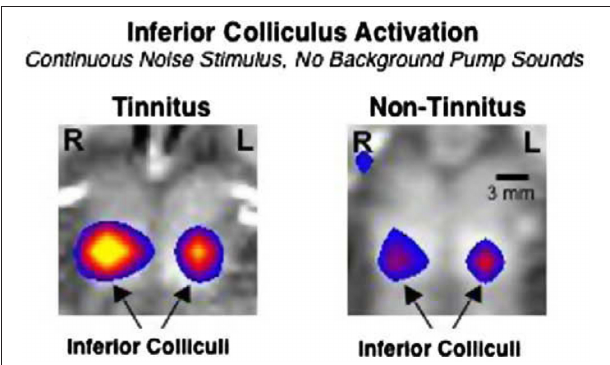
FIGURE 1 | An fMRI imaging study reveals larger sound-evoked activation of the inferior colliculus in patients with tinnitus (left) compared to control subjects (right). The color scale indicates the significance of the difference of activation between on and off stimulus periods. Figure adapted from Melcher et al. (2009).